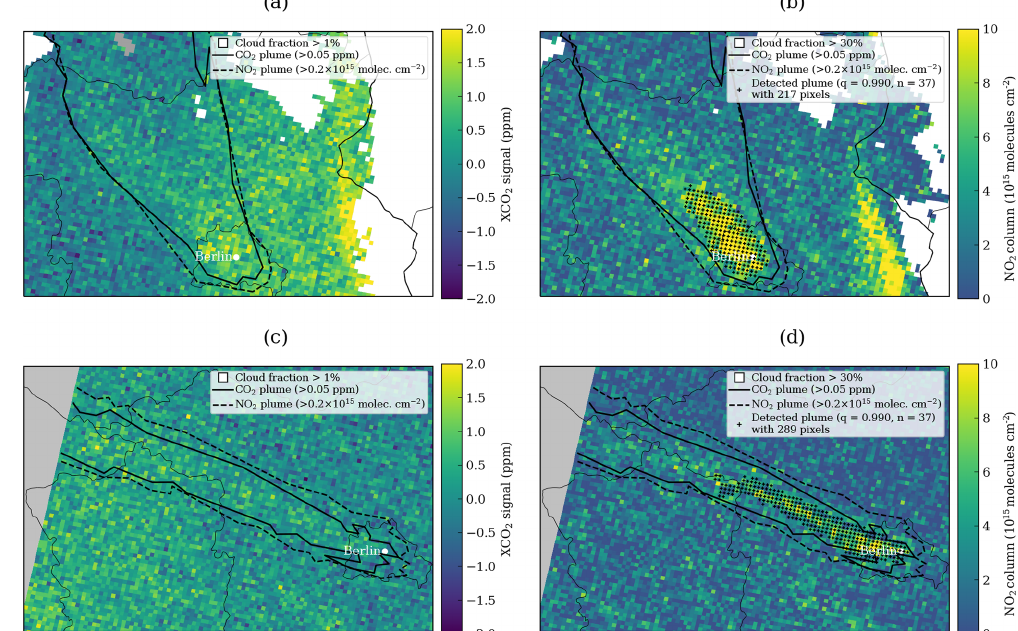
Figure 9. (a) Example of 27 February 2015 where plume detection with a CO 2 instrument fails because of pronounced horizontal gradients in the CO 2 background field. (c) Example of 2 July 2015 where the plume detection fails due to small CO 2 signals as a result of high wind speeds. In both cases, the plume can readily be detected with a high-noise NO 2 instrument (panels b and d